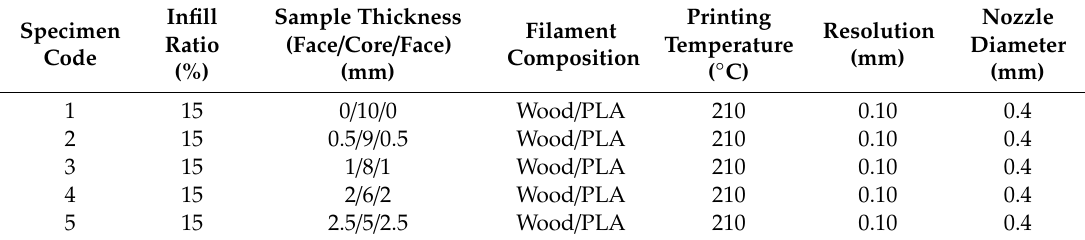
Figure 2. The lattice structures are additively manufactured using wood / PLA filament (reproduced from [17]). Table 1. Experimental design of the specimens with a gyroid-structure